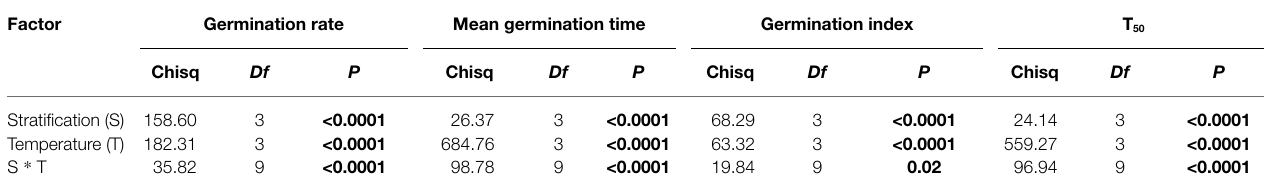
TABLE 2 | Mixed model analysis of germination rate, mean germination time, germination index and T 50 of Spartina alterniflora , cold stratification and temperature as fixed effect with latitude (provenance) as random effect.